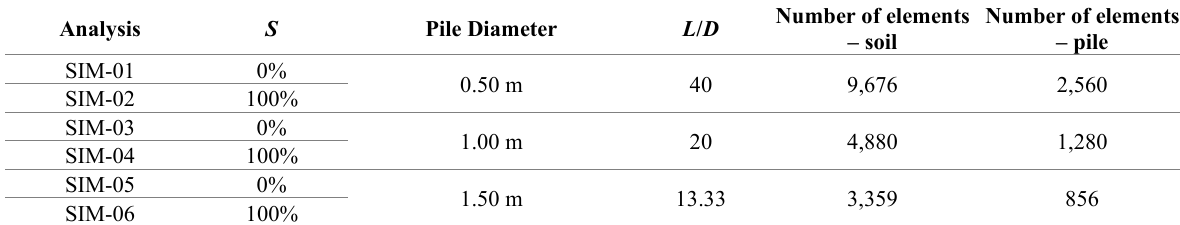
Table 2. Numerical finite element discretization used in the